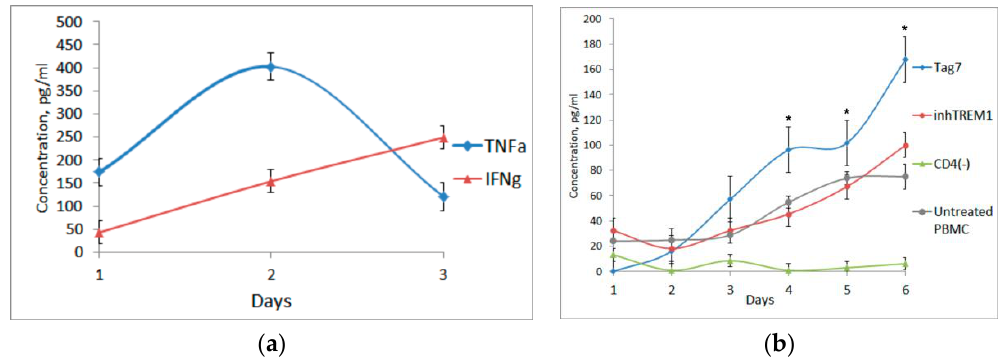
Figure 2. Secretion of proinflammatory cytokines by PBMCs incubated with Tag7 for 1–6 days. ( a ) The medium conditioned by Tag7-activated PBMCs was sampled every 24 h to determine the levels of TNF α and IFN γ by ELISA. ( b ) Secretion of IL-2 by PBMCs incubated with Tag7 for 6 days without additional treatment (Tag7); after blocking TREM-1 receptor on monocytes by inhibitory peptide LP17 (10 −9 M) added 1 h before incubation with Tag7 (inhTREM-1) and after preliminary removal of CD3 + CD4 + lymphocytes by magnetic separation (CD4(–)) and conditioned medium without treatment (Untreated PBMC). The medium conditioned by Tag7-activated PBMCs was sampled every 24 h to determine IL-2 level by ELISA. Data are presented as the mean ± SD of 3 independent experiments. Differences from the control in all cases are significant at * p < 0.05 (2-way ANOVA).